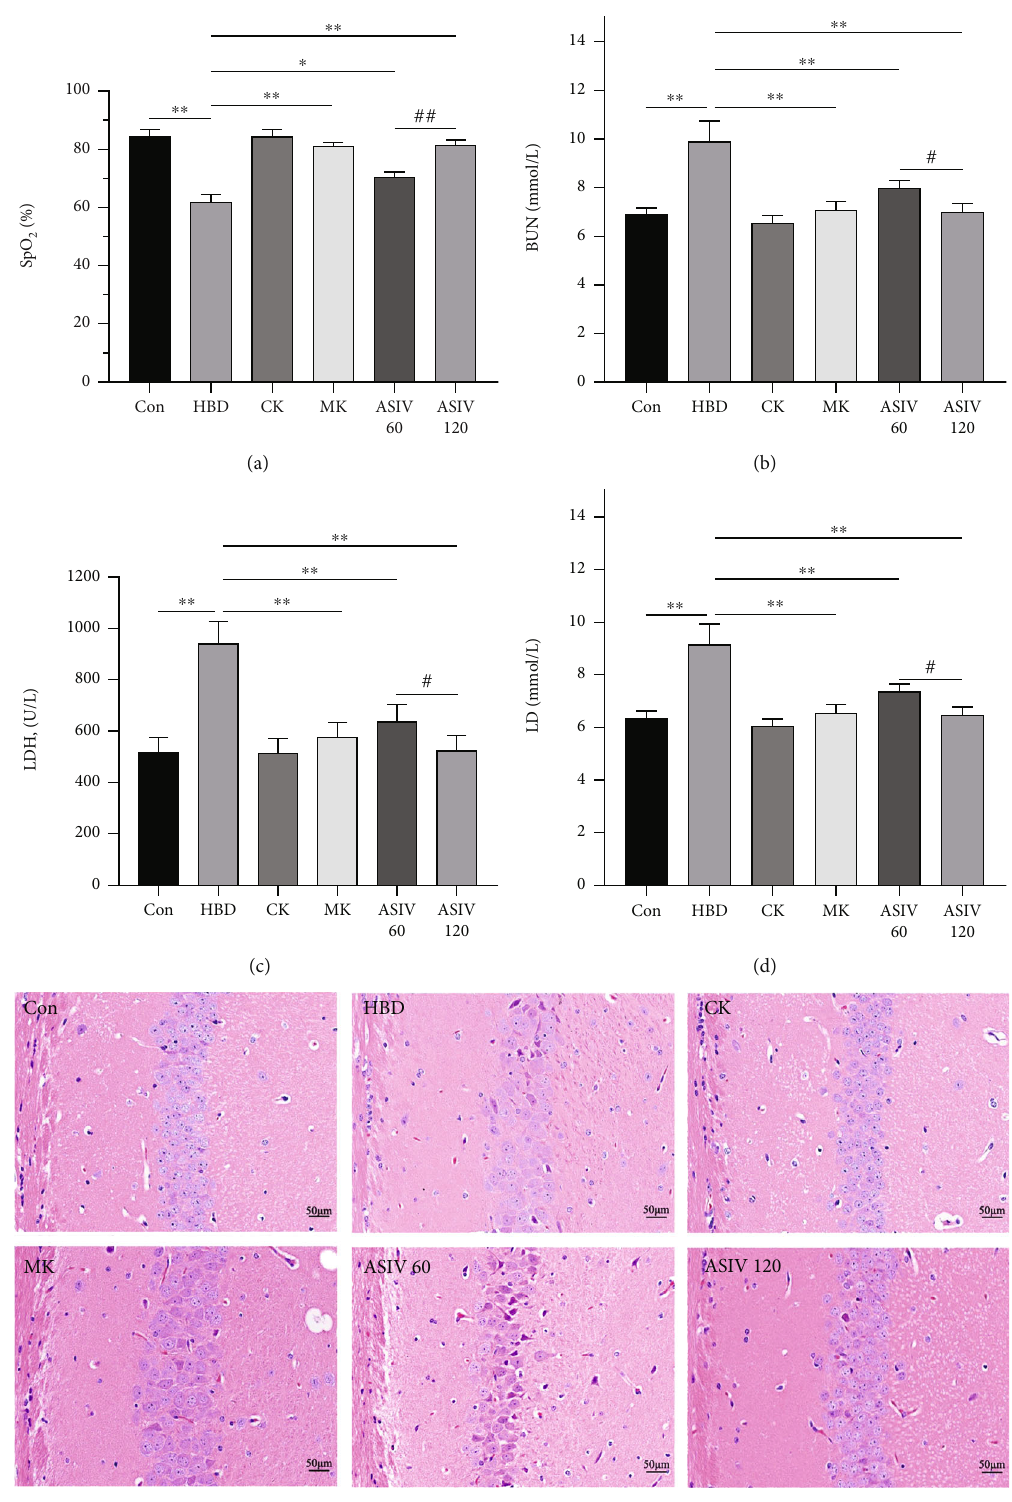
Figure 1: AS-IV and calpain-1 knockout improve hypoxia-induced hippocampal neuronal injury. (a) SpO detected by a blood gas analyzer ( n = 4 ; F ð 5,17 Þ = 62 : 149 ). (b – d) BUN, LDH, and LD determination kit was used to detect the changes in BUN, LDH, and LD, respectively ( n = 4 ; BUN, F ð 5,17 Þ = 27 : 023 ; LDH, F ð 5,17 Þ = 21 : 551 ; LD, F ð 5,17 Þ = 14 : 832 ). (e) HE staining was used to detect pathological changes in the hippocampal CA1 area ( n = 3 ). Data are presented as the mean ± SD . ∗ P < 0 : 05, ∗∗ P < 0 : 01 compared with the HBD group, # P < 0 : 05 , ## P < 0 : 01 compared with the ASIV 60 mg/kg